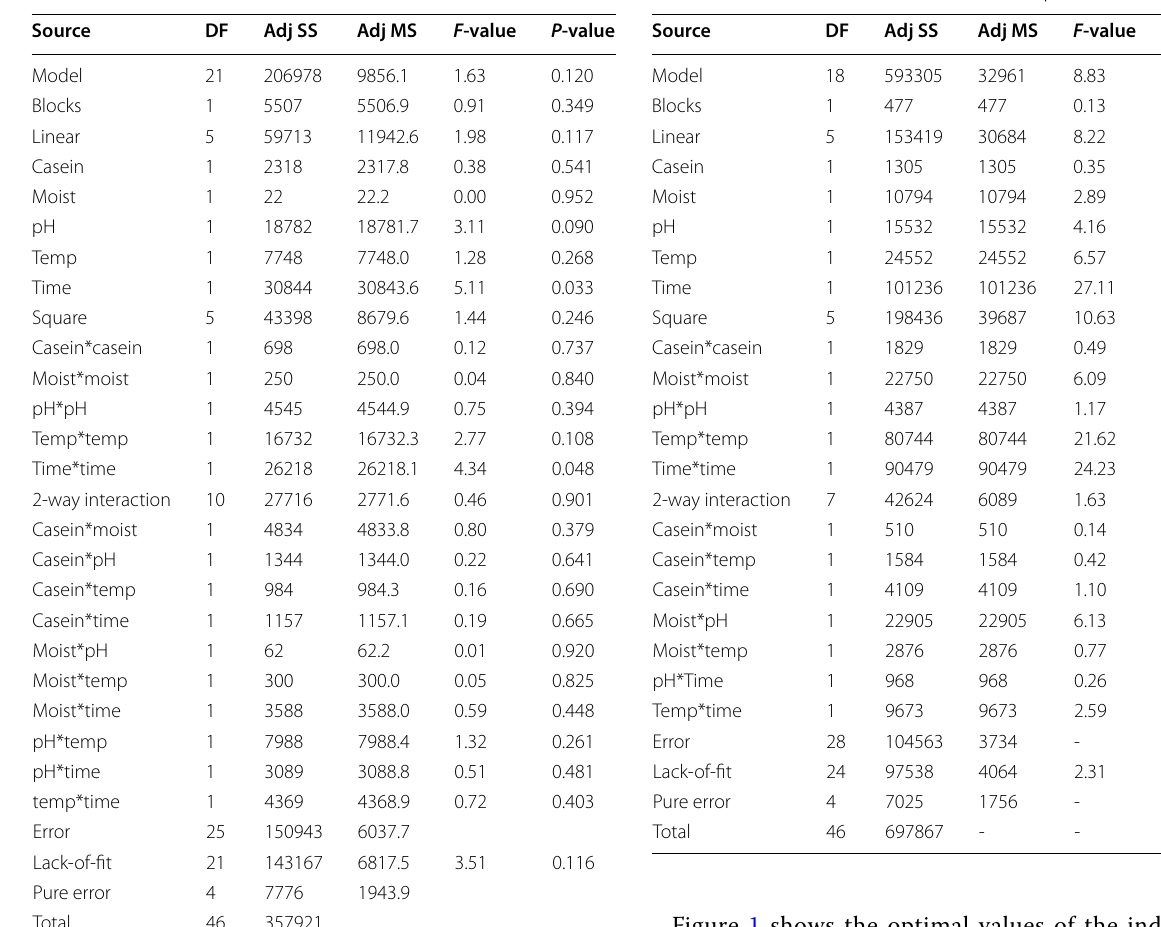
Table 7 ANOVA for the MCA/PA model Table 8 ANOVA for the reduced model of